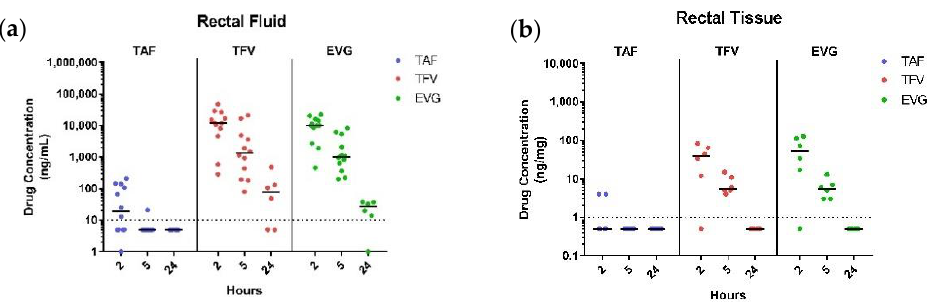
Figure 4. In vivo pharmacokinetics following rectal administration of PEG suppositories containing TAF/EVG (8 mg/8 mg). Drug concentration versus time plots in rectal fluid ( a ) and rectal biopsies ( b ). Dotted line denotes the lower limit of quantitation (LLOQ).